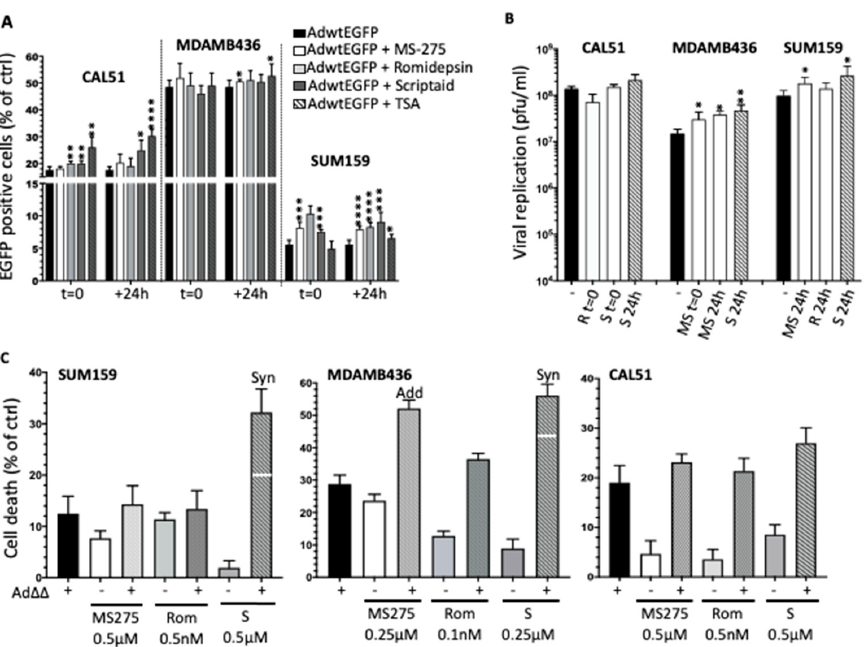
Figure 3. Selective HDACis promote adenovirus-mediated infection, replication and cell killing in TNBC cell lines. ( A ) Percentages of cells expressing EGFP after infection with AdwtGFP (100 ppc) and treated with